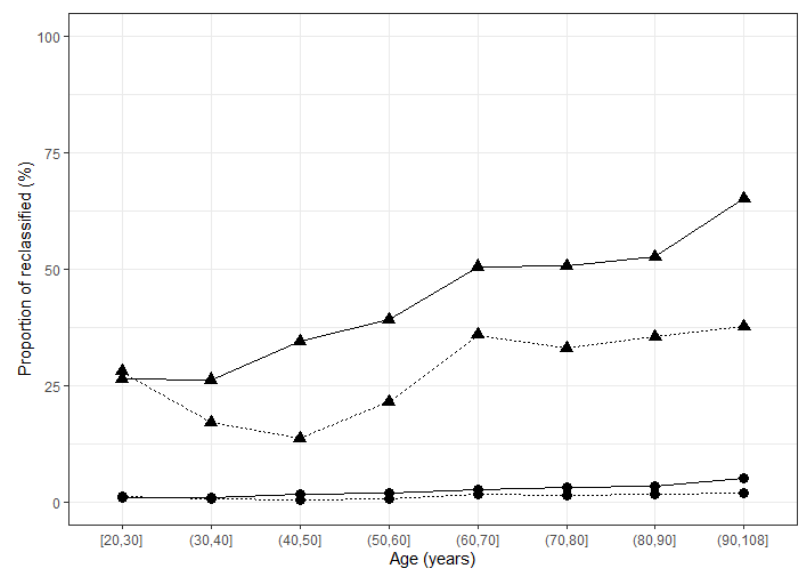
Figure 5. Proportion of patients reclassified according to age group and sex. Solid lines: females; dotted lines: males. Circles: proportion calculated among the total number of samples in the age group; triangles: proportion calculated among samples >4 mUI/L within the age group.